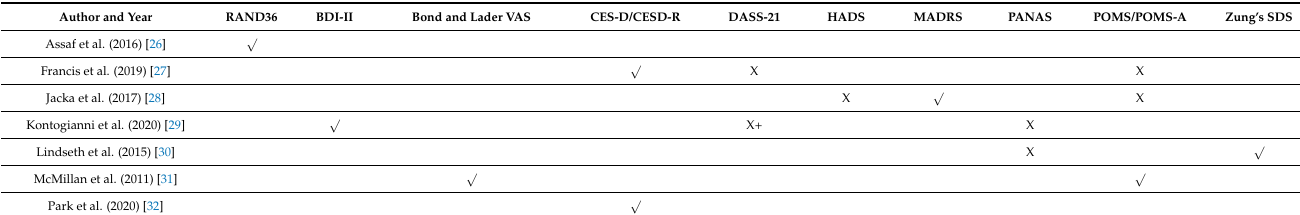
Table 3. Depression Measures